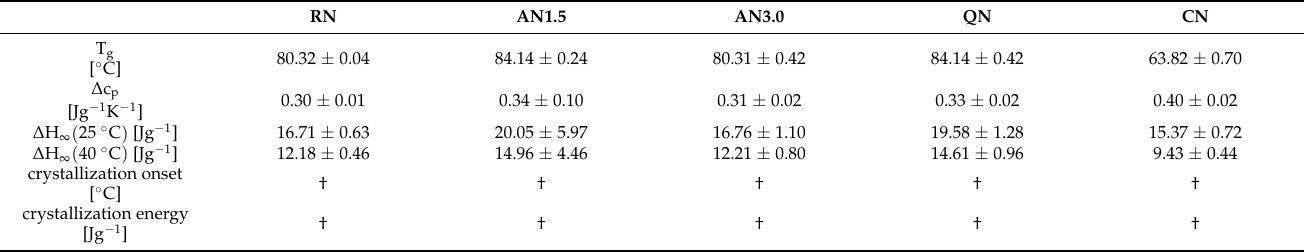
Table A4. Calorimetric data of the 50gl_1.6PS_Suc [ ◦ C]. n = 2, values represent the mean value and the corresponding standard deviation.